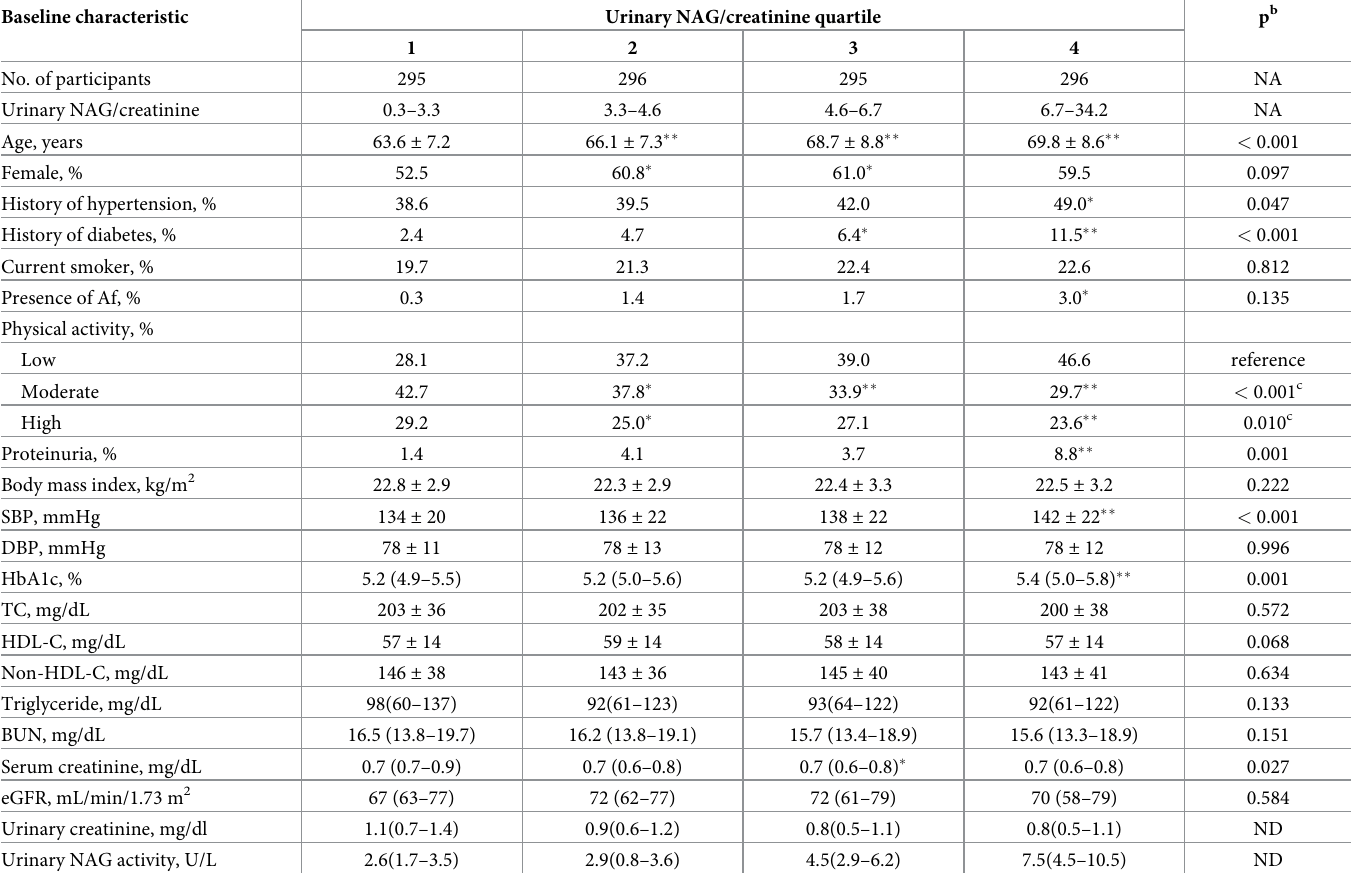
Table 2. Baseline characteristics and risk factors according to urinary N -acetyl- β - D -glucosaminidase activity–urinary creatinine concentration ratio (urinary NAG/ creatinine) quartile a . Baseline